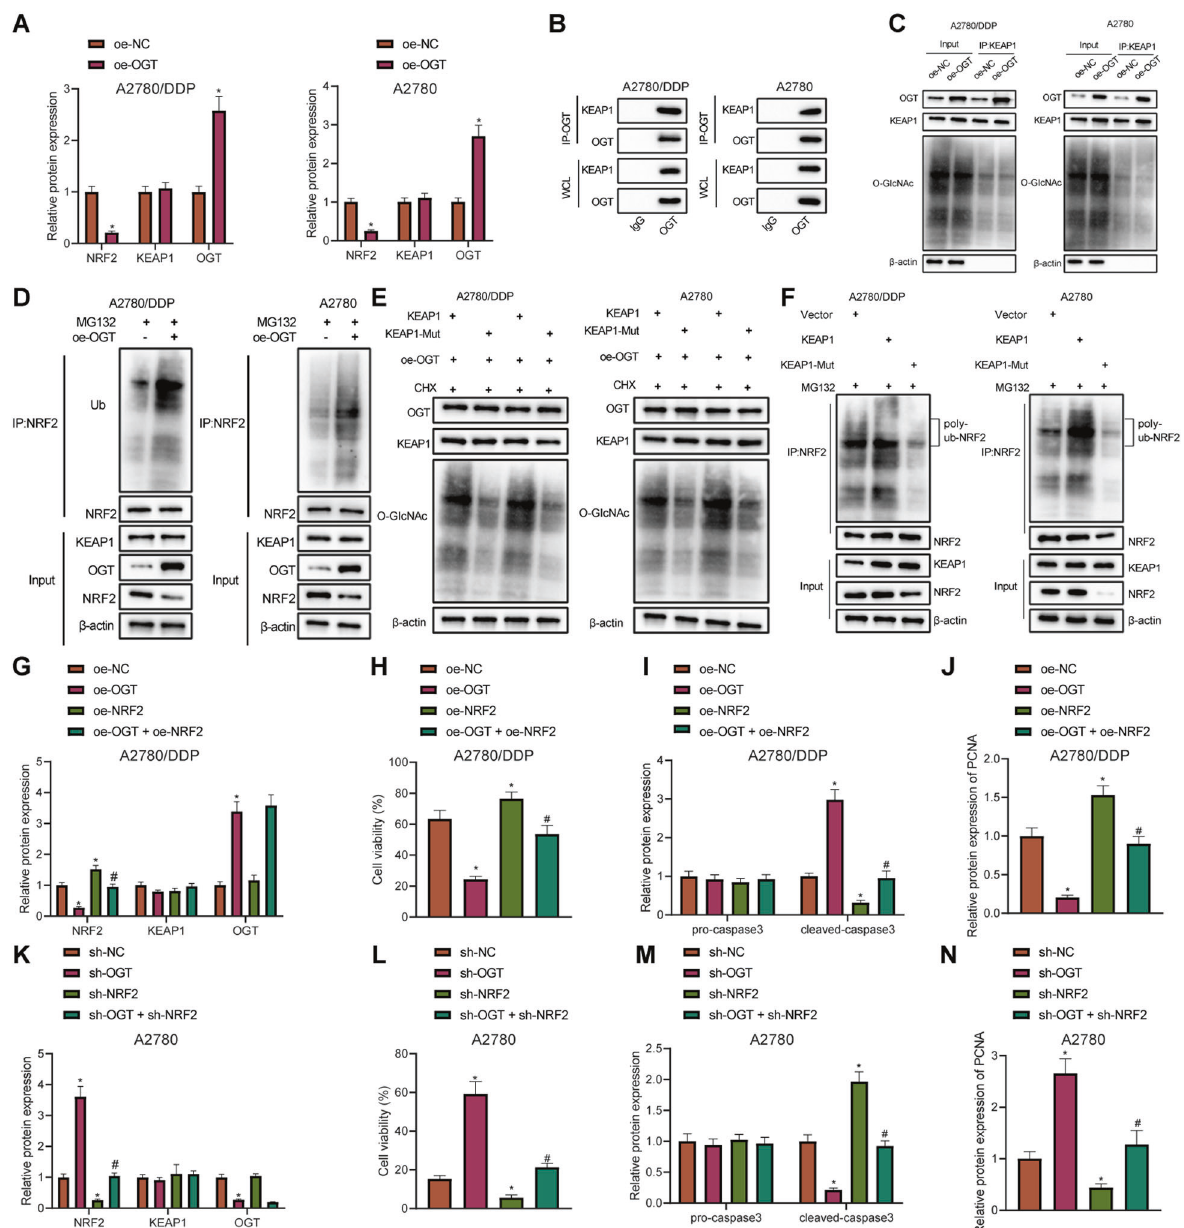
Fig. 5 OGT augments glycosylation of KEAP1, and increases its stability and expression, consequently promoting the ubiquitination and degradation of NRF2, and thereby inhibiting DDP resistance of OC cells. A Western blot assay of the expression and quantitative analysis of KEAP1 in A2780 and A2780/DDP cells overexpressing OGT normalized to β -actin. B Co-IP assay of the interaction between OGT and KEAP1 in A2780 cells or A2780/DDP cells. C Co-IP assay of KEAP1 glycosylation in A2780 cells or A2780/DDP cells. D Co-IP assay of the ubiquitination modi fi cation level of NRF2 in A2780 cells or A2780/DDP cells. E Western blot assay of changes in KEAP1 glycosylation in A2780 cells or A2780/ DDP cells. F Co-IP assay of the ubiquitination degree of NRF2 in A2780 cells or A2780/DDP cells. A2780/DDP cells were treated with oe-NC + sh-NC, oe-OGT, oe-OGT + sh-KEAP1 or oe-OGT + oe-NRF2. G Western blot assay of the expression and quantitative analysis of OGT, KEAP1, and NRF2 in A2780/DDP cells normalized to β -actin. H CCK-8 assay of the change of A2780/DDP cell viability. I Western blot assay of cleaved caspase-3 expression and quantitative analysis in A2780/DDP cells normalized to β -actin. J Western blot assay of PCNA expression and quantitative analysis in A2780/DDP cells normalized to β -actin. A2780 cells were treated with oe-NC + sh-NC, sh-OGT, sh-OGT + oe-KEAP1 or sh-OGT + sh-NRF2. K Western blot assay determination of KEAP1, OGT, and NRF2 expression and quantitative analysis in A2780 cells normalized to β -actin. L CCK-8 assay assessment of A2780 cell viability. M Western blot assay of the cleaved caspase-3 expression and quantitative analysis in A2780 cells normalized to β -actin. N Western blot assay of PCNA expression and quantitative analysis in A2780 cells normalized to β -actin. Cell experiments were repeated three times independently. * p < 0.05 versus A2780/DDP or A2780 cells treated with oe- NC, A2780/DDP or A2780 cells treated with sh-NC or A2780/DDP or A2780 cells treated with oe-NC + sh-NC. # p < 0.05 versus A2780/DDP cells treated with oe-OGT or A2780 cells treated with sh-OGT.